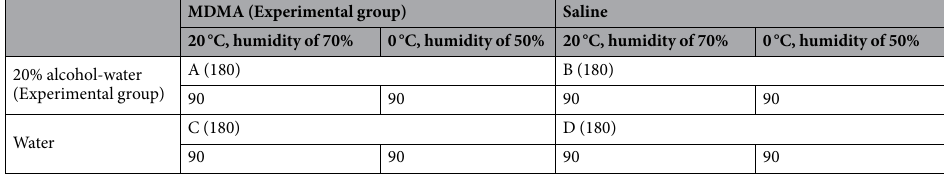
Table 1. Grouping of Combined-Use Rats. A: Acute Combined-use of Alcohol + MDMA. B: Chronic Self- drinking of Alcohol. C: Acute Use of MDMA. D: